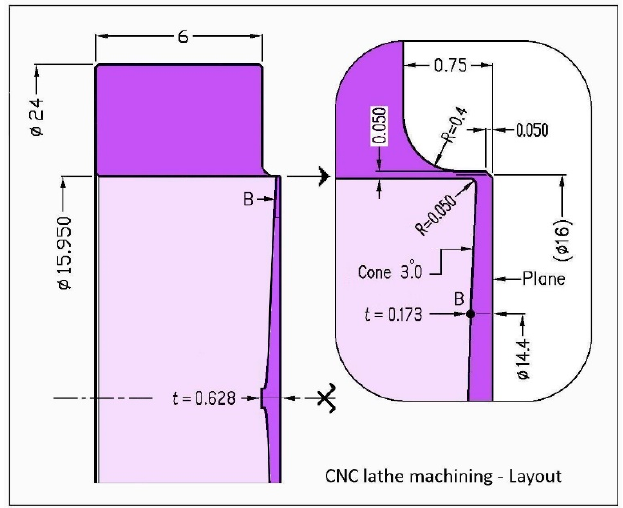
Figure 12. Definition layout for the CNC lathe ‐ turning execution. Dimension units (mm).